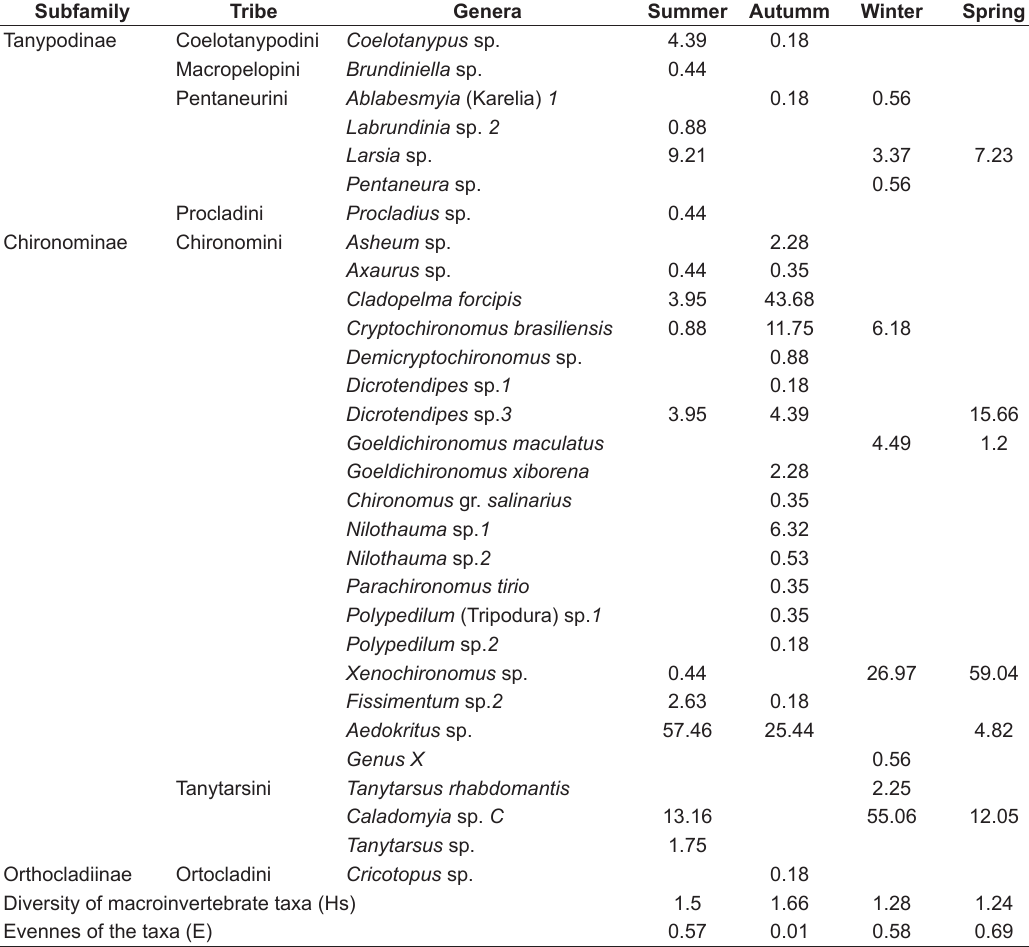
Table 2. Seasonal distribution of Chironomidae in Lake Figueira, central coast of Rio Grande do